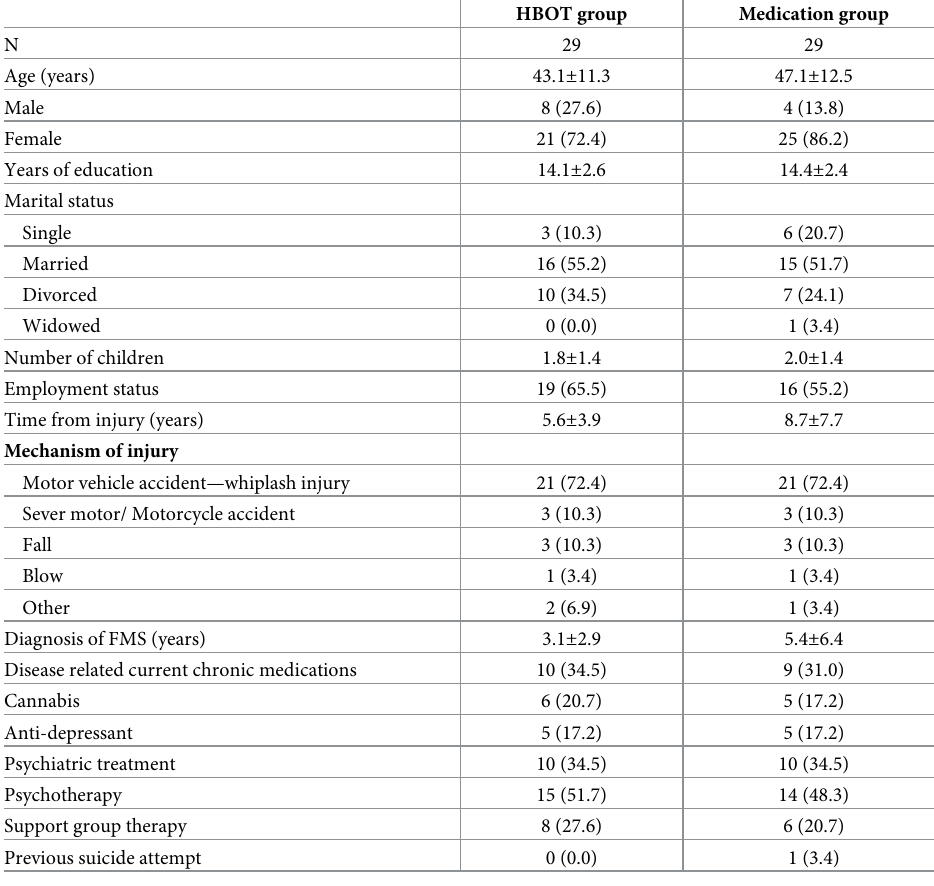
Data presented as n (%); continuous data, mean ±